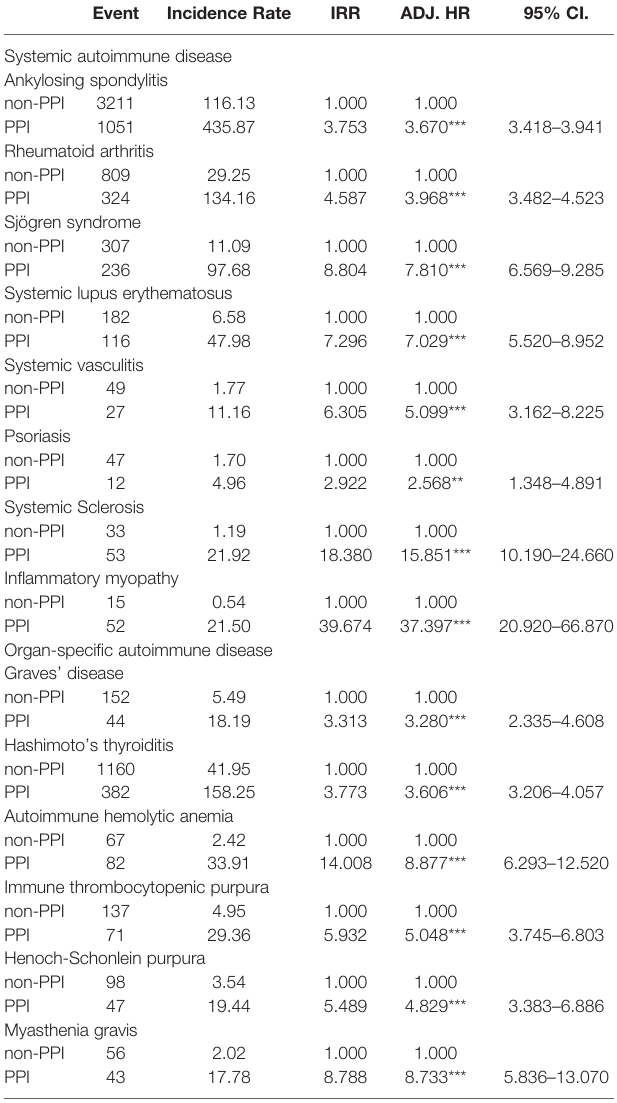
TABLE 4 | Risk of organ-speci fi c and systemic autoimmune diseases between PPI and non-PPI users. Event Incidence